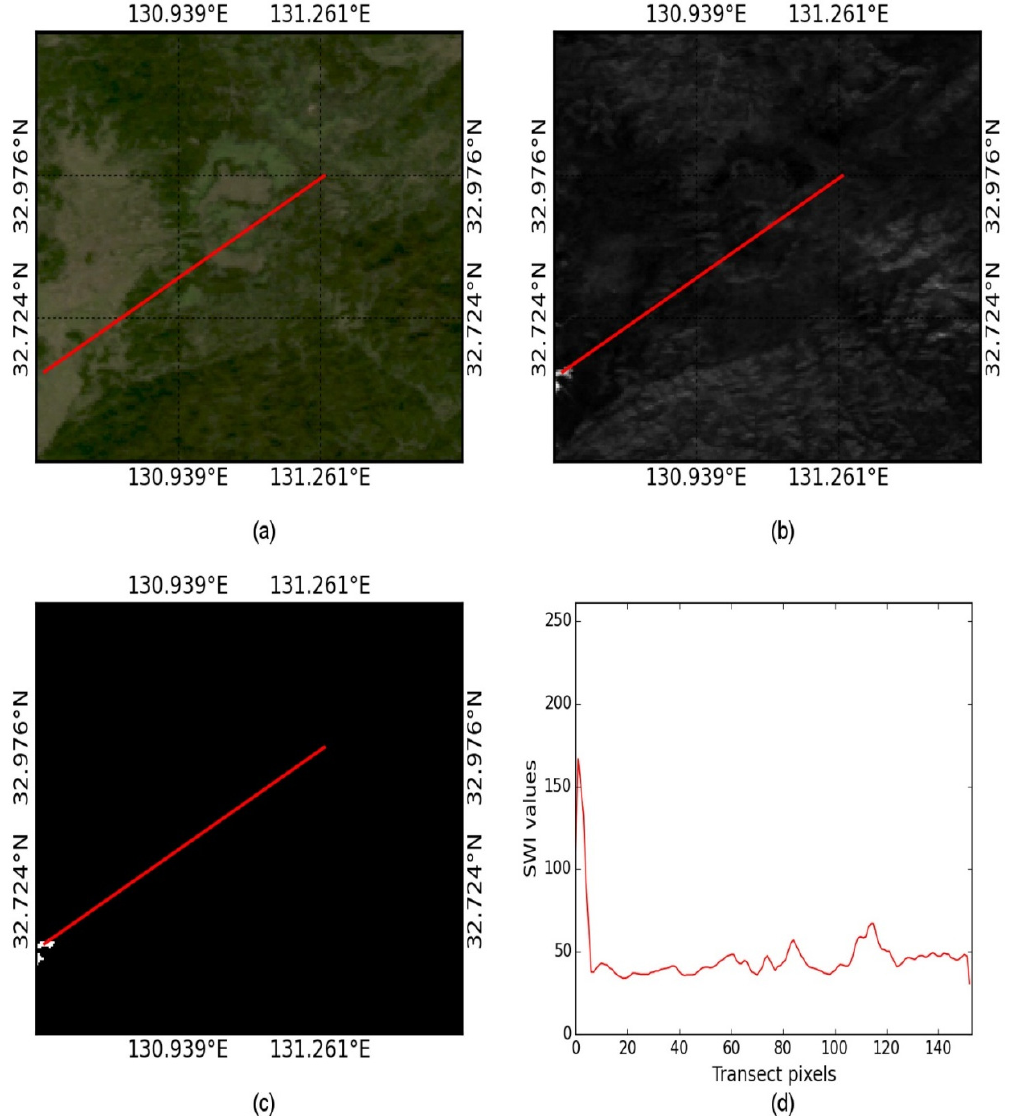
Figure 20. Performance of SWI based extraction of water cover in the case of volcanoes: ( a ) MODIS true-color image, ( b ) SWI image, ( c ) Extracted water cover, ( d ) Profile plot of SWI along the red line